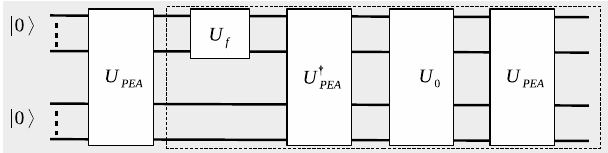
Figure 2: The general quantum algorithm to find the principal components of W. The dashed box indicates an iteration of the amplitude